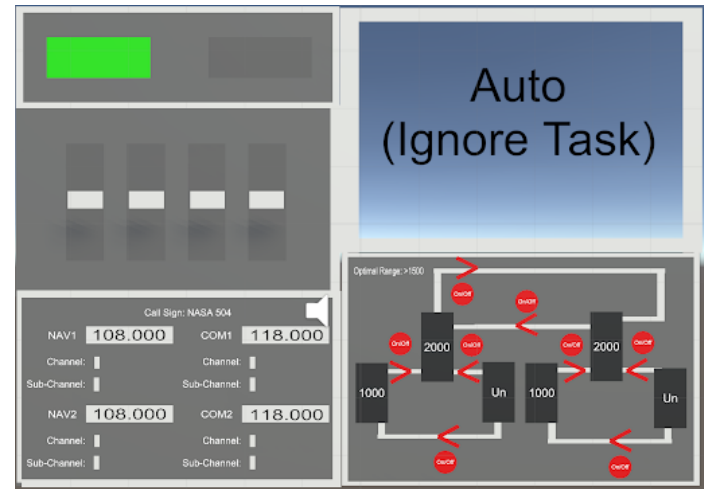
Figure 5. Implementation in virtual reality of the MATB-II system.